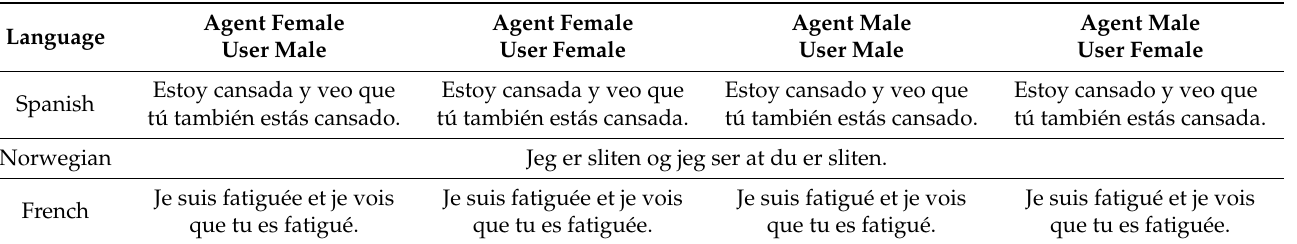
Table 2. The importance of “gender” (“Male” and “Female”) attribute in the three EMPATHIC languages addressed by